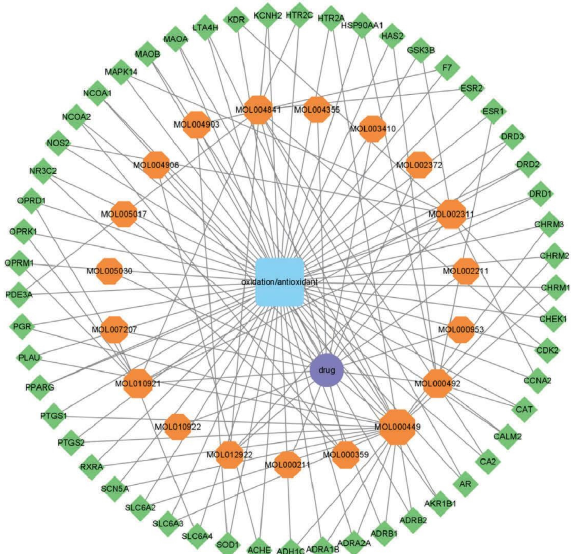
Figure 2: Network of active ingredients and potential targets for antioxidant intervention in bitter almonds. Note: blue indicates disease; purple indicates drug; orange indicates bitter almond active ingredient; and green indicates predicted target.